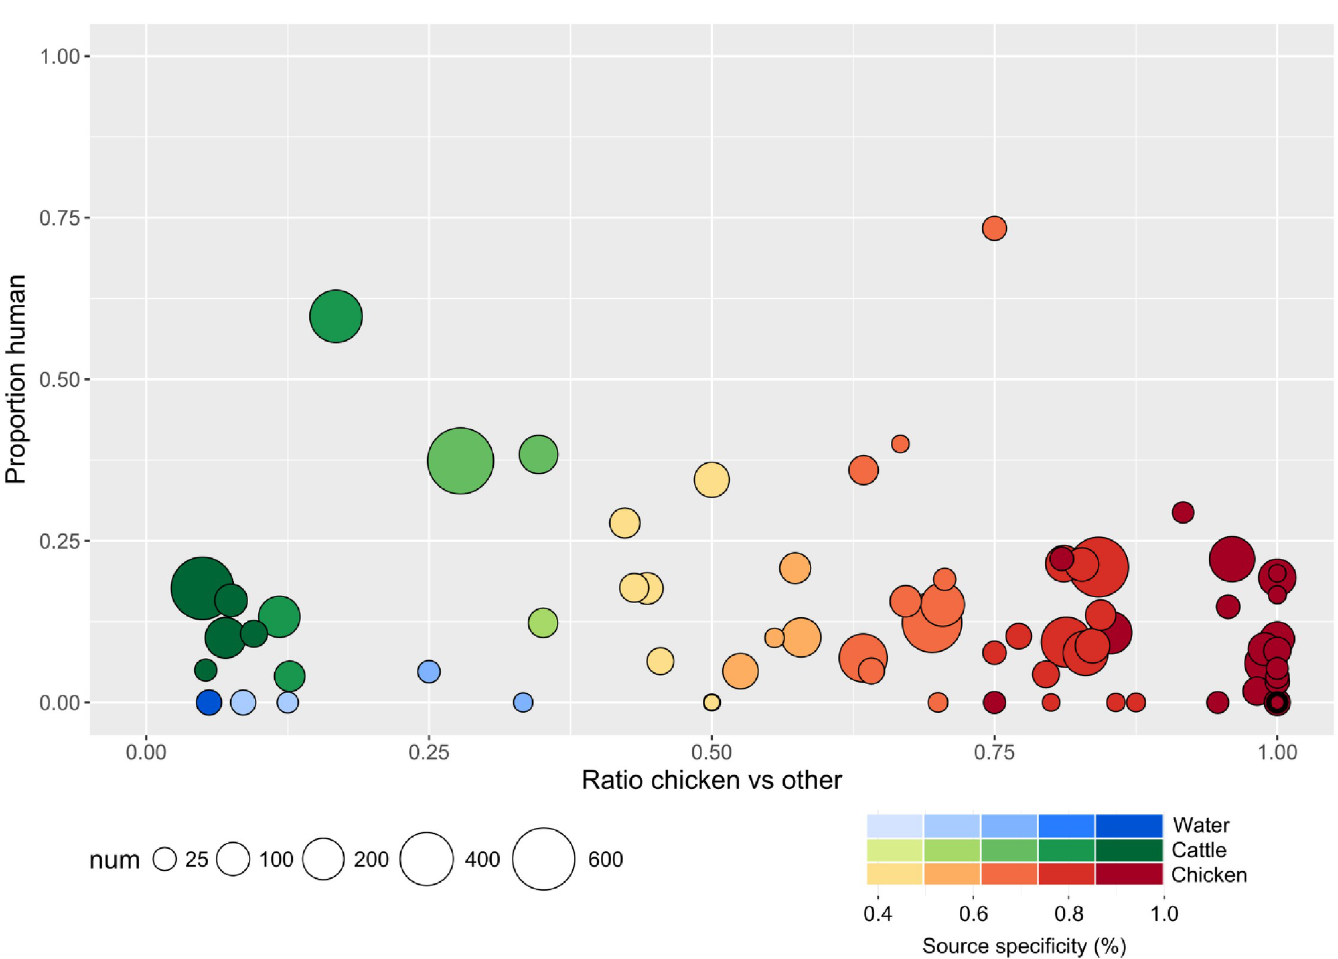
Fig 5. Degree of non-human and human source association among chicken subtypes observed in Nova Scotia. Along the x-axis, we show the degree of chicken association, expressed as the ratio of the number of isolates from non-chicken sources (cattle, swine, water, wild, other) vs. the number of isolates from chicken. Along the y-axis, we show the level of human clinical association, where the number of clinical isolates is shown as a proportion of the total number of isolates in that subtype. The degree of shading is used to indicate the level of source specificity.